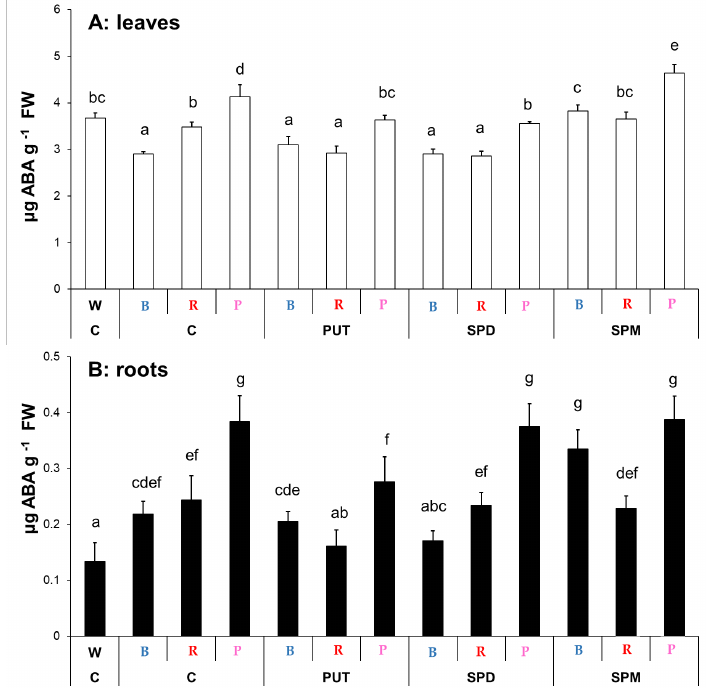
Figure 4. Abscisic acid (ABA) contents in the leaves ( A ) and roots ( B ) of plants grown under different light regimes (white light: W, blue light: B, red + far-red: R and the combination of blue and red + far-red, pink: P) treated with or without polyamines (control: C, putrescine: PUT, spermidine: SPD and spermine: SPM). Values are means ± SD ( n = 3). Different letters indicate statistically significant differences at p < 0.05 level, using Duncan’s post hoc test.